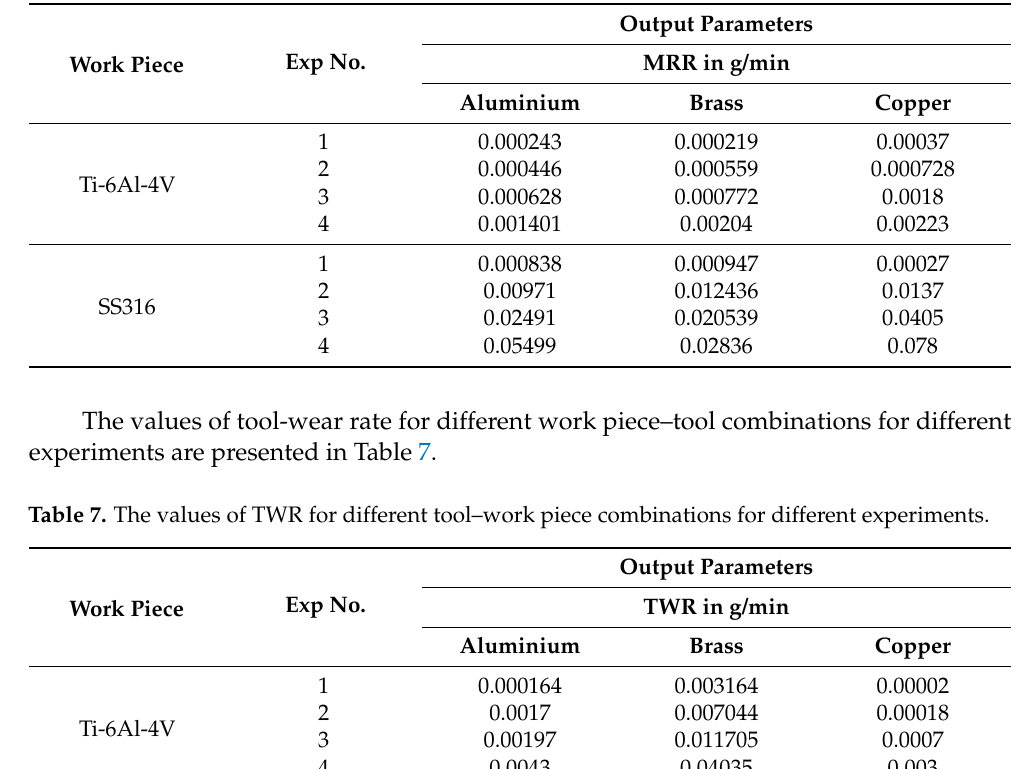
Table 6. The values of MRR for different tool–work piece combinations for different experiments.